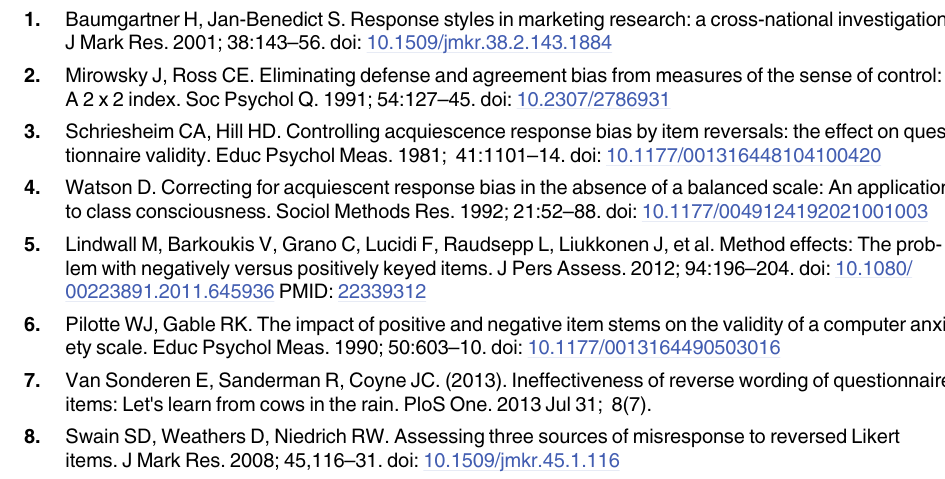
S1 Table. Robust Chi-Square Difference Tests. The robust chi-square difference tests are con- ducted according to Satorra and Bentler ’ s approach. ns = not significant (i.e., p -value